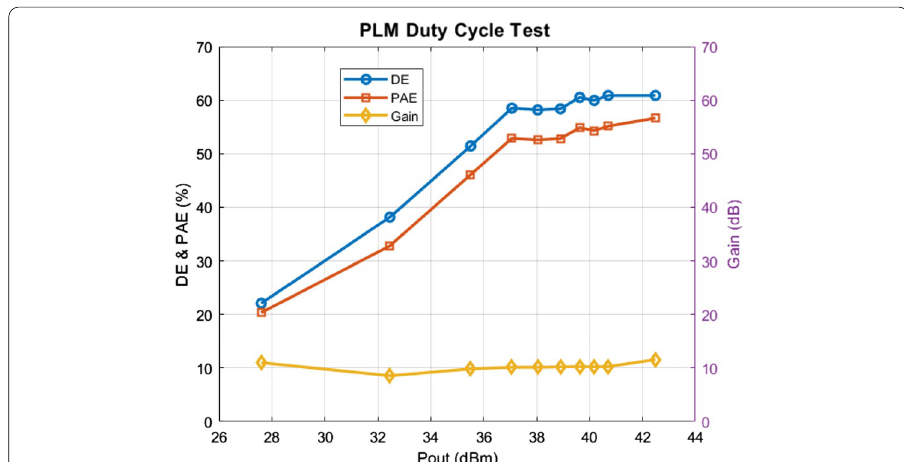
Fig. 15 Measured PA drain efficiency, power added efficiency and gain of two combined PLM units